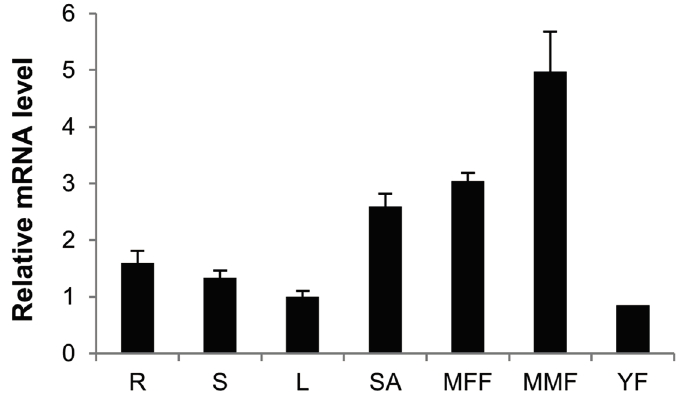
Figure 7. Expression patterns of CsCTR1 in different organs of cucumber. Expression levels were assessed by qRT-PCR and were normalized to cucumber Actin3 . Each result was the average of three independent biological replicates. Error bars on each point indicate standard deviation. R, roots; S, stem; L, leaves; SA, shoot apices; MMF, mature male flowers; MFF, mature female flowers; YF, young